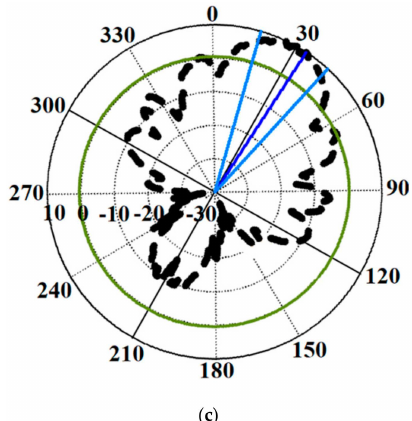
Figure 3. Radiation characteristics of the proposed 1 × 2 MTM-LWA array at 55 GHz, 60 GHz, and 65 GHz. ( a ) Backward-radiation at 55 GHz; ( b ) broadside-radiation at 60 GHz; ( c ) forward-radiation at 65